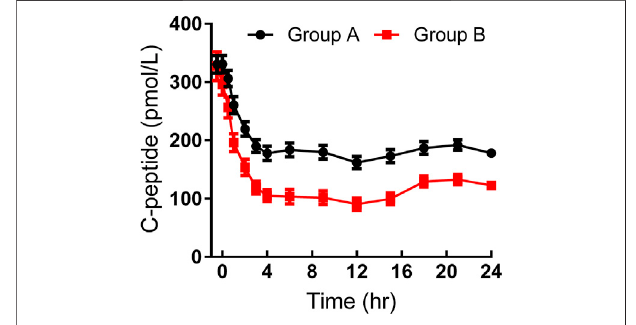
FIGURE 1 | Time-pro fi les of serum C-peptide throughout the euglycemic clamp in groups A and B, respectively (Mean ±